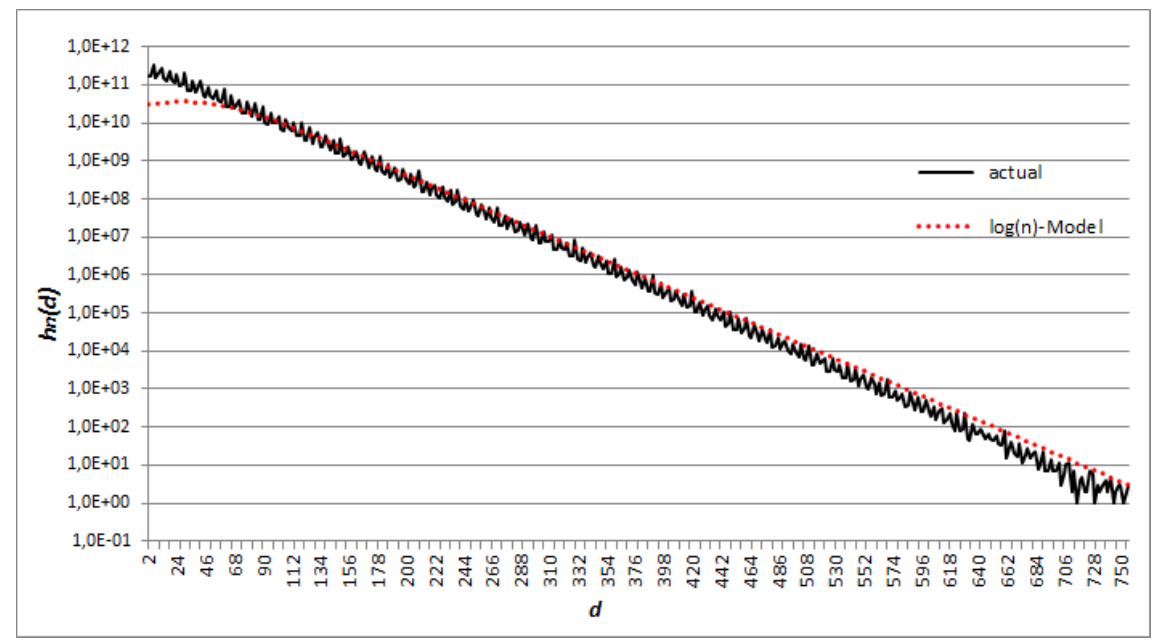
Figure 2. Numbers of successive prime pairs as function of the gap d = p n + 1 − p n in 4,461,632,979,716 ≤ n ≤ 8,731,188,863,469 (logarithmic